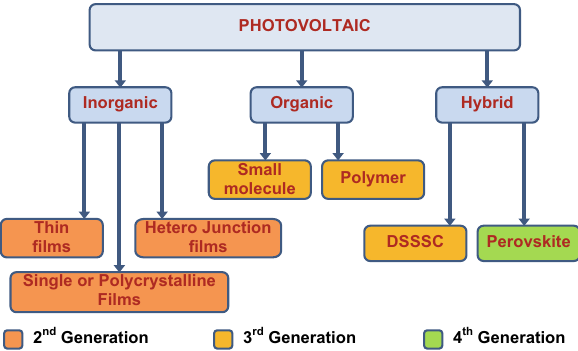
Fig. 2 Classifications of photovoltaics corresponding to inorganic, organic, and hybrid perovskites